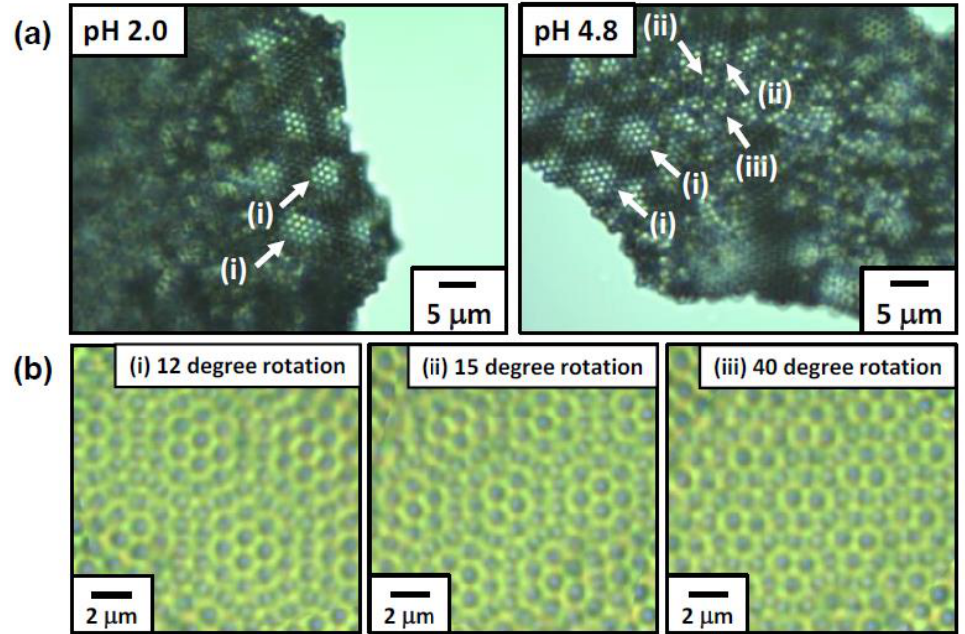
Figure 6. ( a ) Moiré patterns produced by ACMPA-PS particle bilayers as observed by optical microscopy. ( b ) Simulation images obtained by superimposing a semi-transparent (40% transmission) optical micrograph image of a hexagonally ordered particle array onto the identical non-transparent image after rotation of the semi-transparent image through angles of 15, 40 and 50° relative to the non-transparent image.